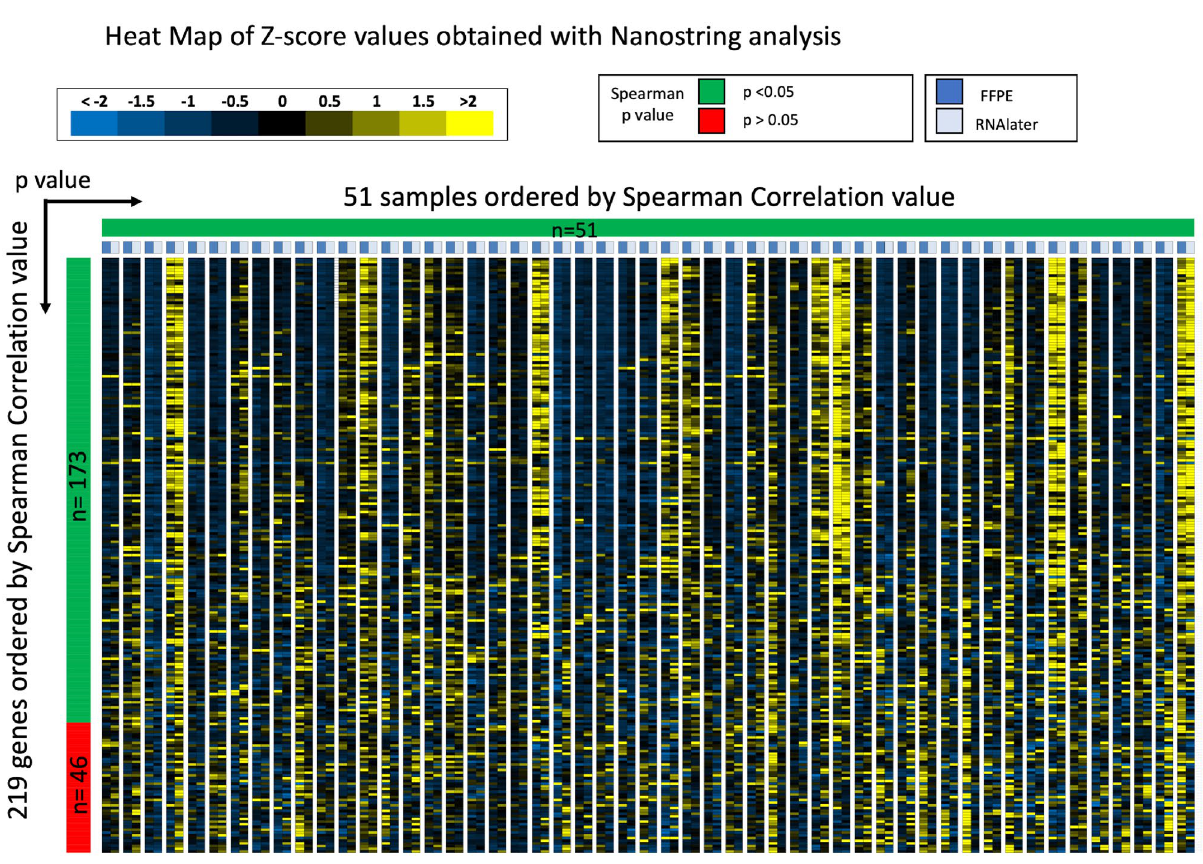
Figure 2. Representation by heat map of Z-score values obtained with NanoString analysis of FFPE and RNAlater matched samples. This graph represents the gene expression levels measured by Nanostring after Z-score transformation. Each row represents a gene, and each column represents a sample. Each column is double, with a dark blue box at the top of the column indicating Z-scores in the FFPE sample and a light blue box at the top of the column indicating Z-scores of the corresponding RNAlater sample. The heatmap colour range is from yellow for positive Z-scores values to blue for Z-score negative values. Samples are ordered horizontally from left to right according to their Spearman rank p value. Genes are ordered vertically from top to bottom by their Spearman rank p value. The results of the Spearman rank p value are also represented along the horizontal and vertical bars, where green represents p < 0.05 and red p >